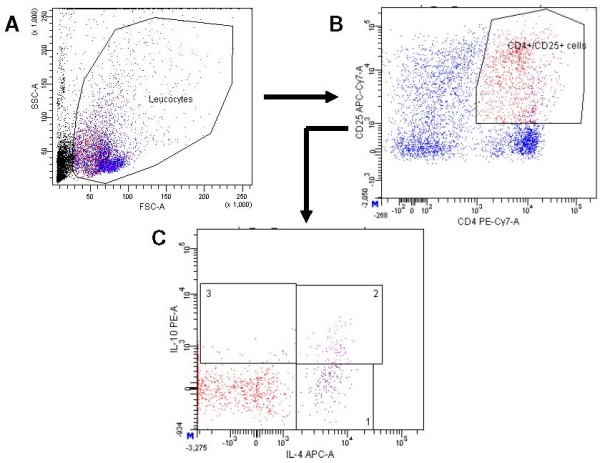
Representative example of the flowcytometric analysis of the IL-10 secreting CD4+CD25+ population of PBMCs stimulated with malaria extract for 7 days. A. Leukocytes were identified by forward (FSC) and sideward (SSC) scatter. B. Of these leukocytes staining was performed with CD4-PE-Cy7-A and CD25-APC-Cy7-A labeled monoclonal antibodies from BD Pharmingen. C. The CD4+CD25+ double positive cells were stained intracellularly with IL-4 APC-A and IL-10 PE-A labeled monoclonal antibodies from BD Pharmingen. Panel 1 contains 14% IL-4 single positive CD4+CD25+ cells, panel 3 contains 2.5% IL-10 single positive CD4+CD25+ cells, and panel 2 contains 7.2% IL-4+IL-10+ double positive CD4+CD25+ cells.